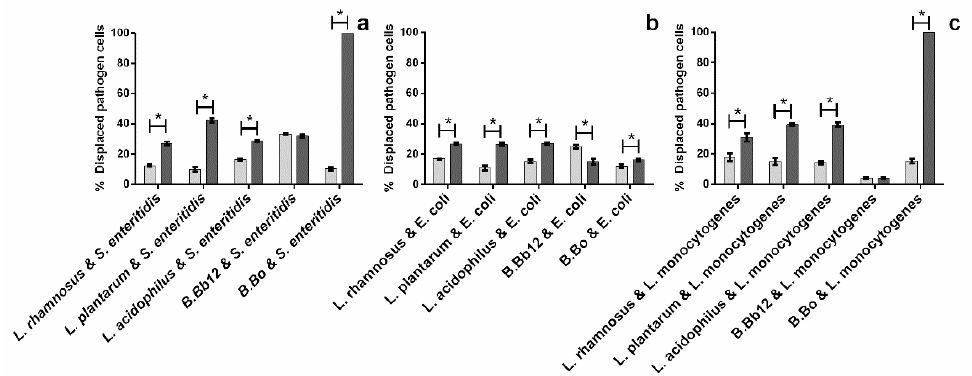
Figure 5. Impact of blueberry extract (presence ( ) and absence ( ) of extract) upon adhered pathogenic microorganisms’ displacement in a pathogen/probiotic system. ( a ) S. enteritidis /probiotic system, ( b ) E. coli /probiotic system, and ( c ) L. monocytogenes /probiotic system. The asterisks (*) mark statistically significant differences between sets of data ( p < 0.05).